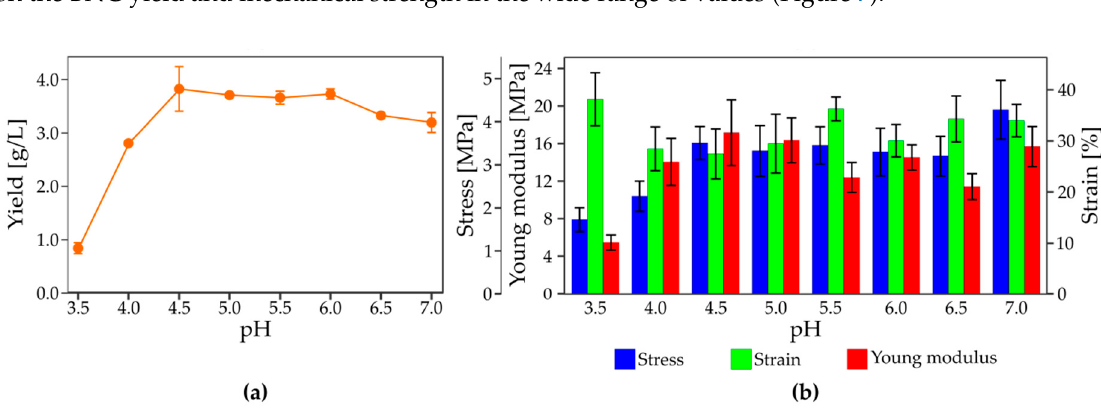
Figure 7. Impact of pH on ( a ) biosynthesis yield and ( b ) tensile parameters of bacterial nanocellulose.